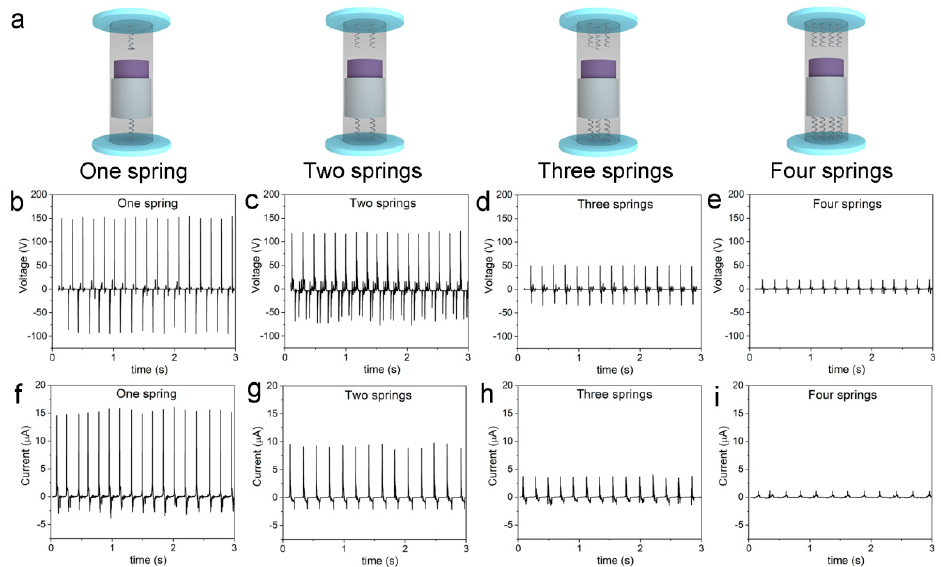
Figure 3. ( a ) Prototype designs of the CS-TENGs with different numbers of springs, reflecting the difference in stiffness coefficient. ( b – e ) Output voltage results of CS-TENGs with 1–4 springs fixed on each end of the device. ( f – i ) Output current results of CS-TENGs with 1–4 springs fixed on each end of the device.